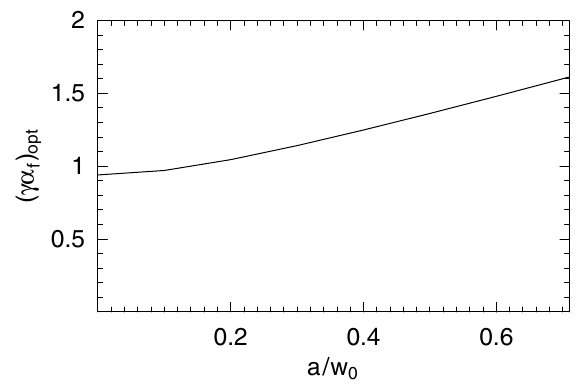
FIG. 4. The optimal laser focusing angle as a function of the hole radius at the material damage